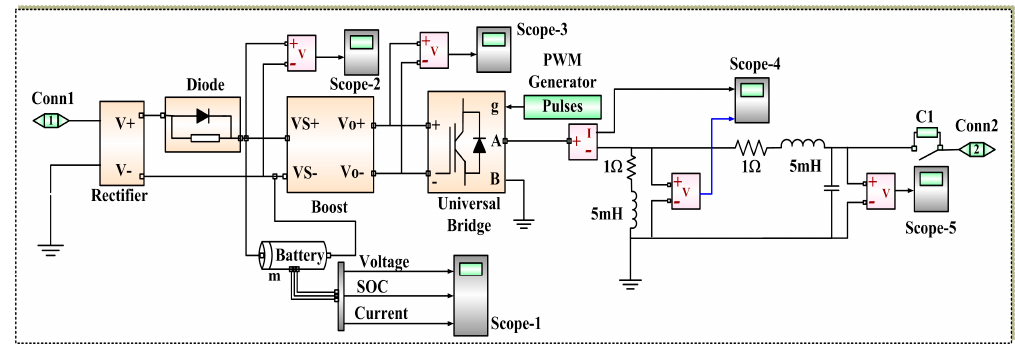
Figure 4. Simulink model of the online UPS.